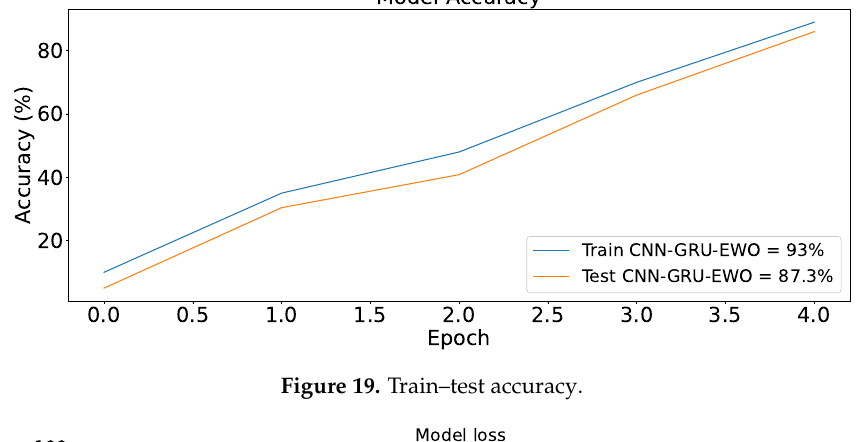
Figure 19. Train–test accuracy.